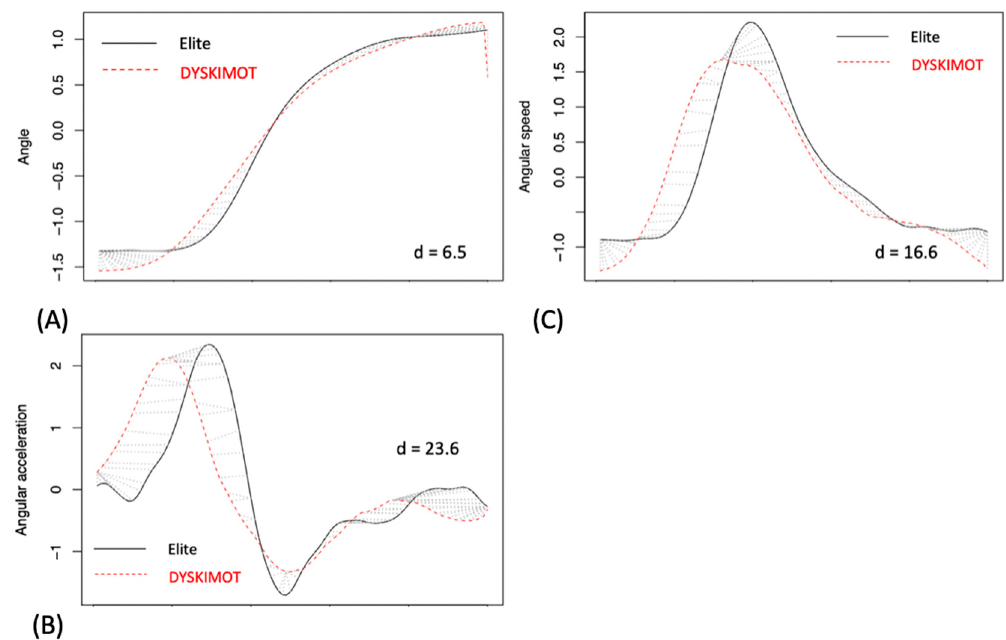
Figure 9. Typical plots of DTW matching between Elite (black solid lines) and DYSKIMOT (red dashed lines) analyzed for z-normalized data in one NDP (22 years, Male, NDI = 0, NRPS = 0) participant: ( A ) Angle, ( B ) Angular acceleration, ( C ) Angular speed. The DTW distance is added for completeness.